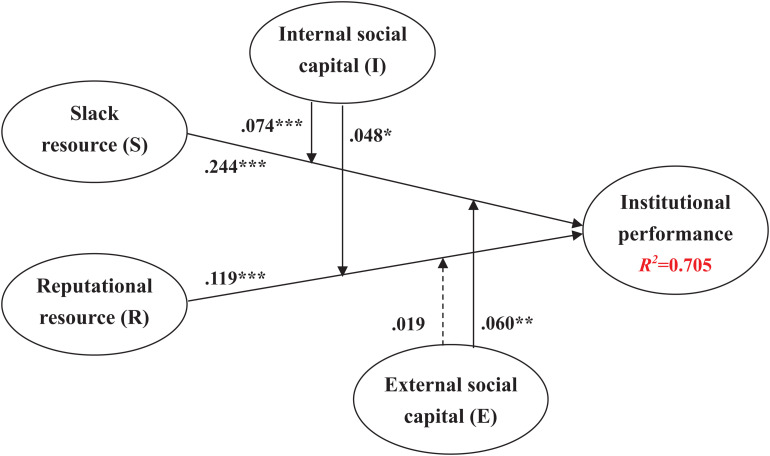
Structural model. ∗p < 0.05; **p < 0.01; ***p < 0.001.